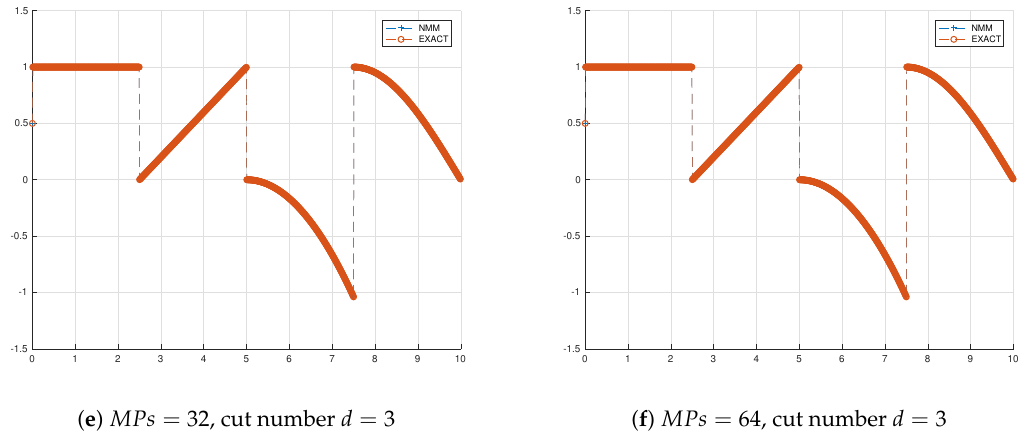
Figure 8. With the increase in the number of mathematical patches, the result of using NMM approximation is getting closer and closer to the real solution. Therefore, the convergence of this method can be verified.